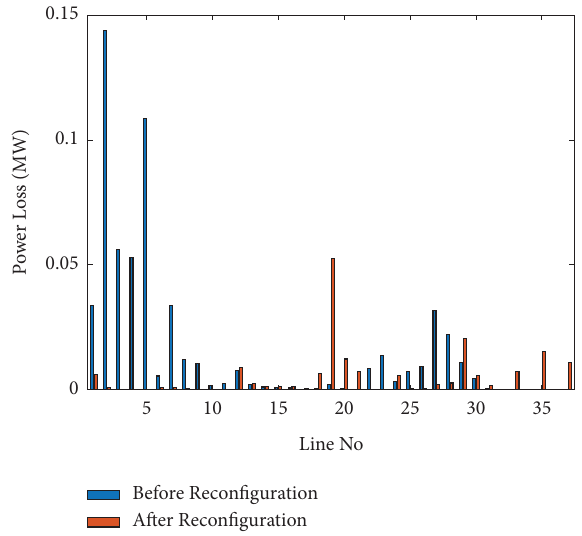
Figure 12: Each line losses in 33-bus system heavy load before and after